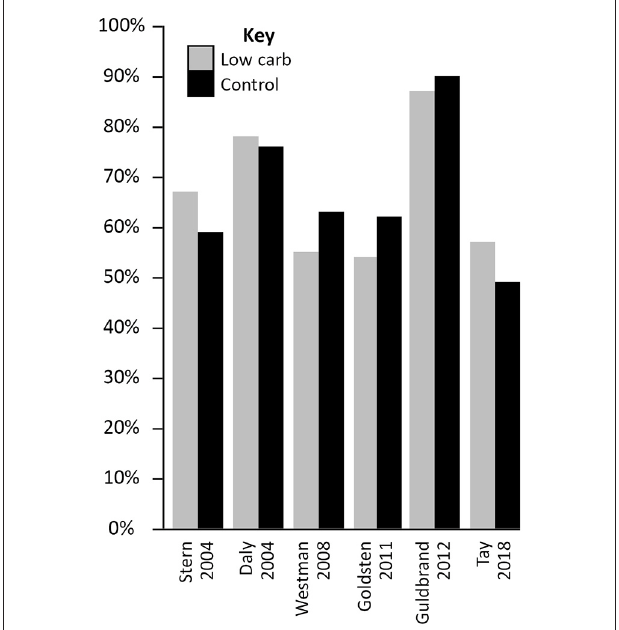
FIGURE 4 | Study completion rates in randomised controlled trials comparing low carbohydrate dietary approaches (carbohydrate intake below 130 g/day or 26% total energy) with any control diet in people with Type 2 diabetes (minimum 50 participants and 3 months